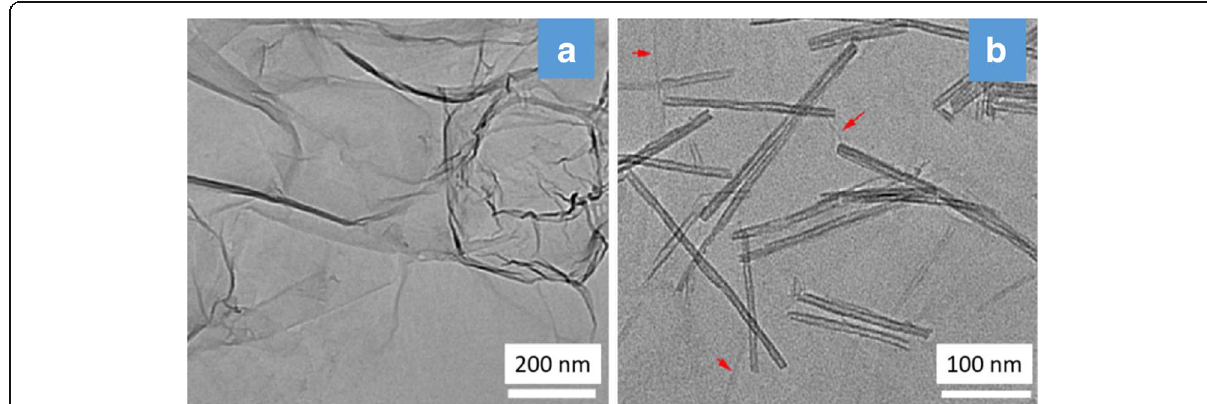
Fig. 2 TEM images of a GO and b TNTs/GO nanocomposites. GO nanosheets exhibit a layered structure and a typical crumpled morphology, while the surface of TNTs/GO nanocomposite is relatively smooth and contains a small amount of unconspicuous and slight wrinkle,